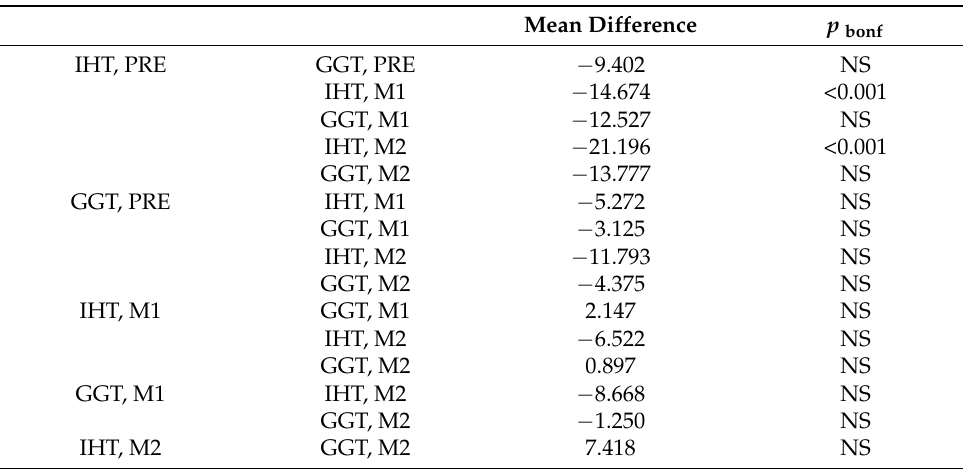
Table 3. Post hoc comparison–GROUP * TIME.